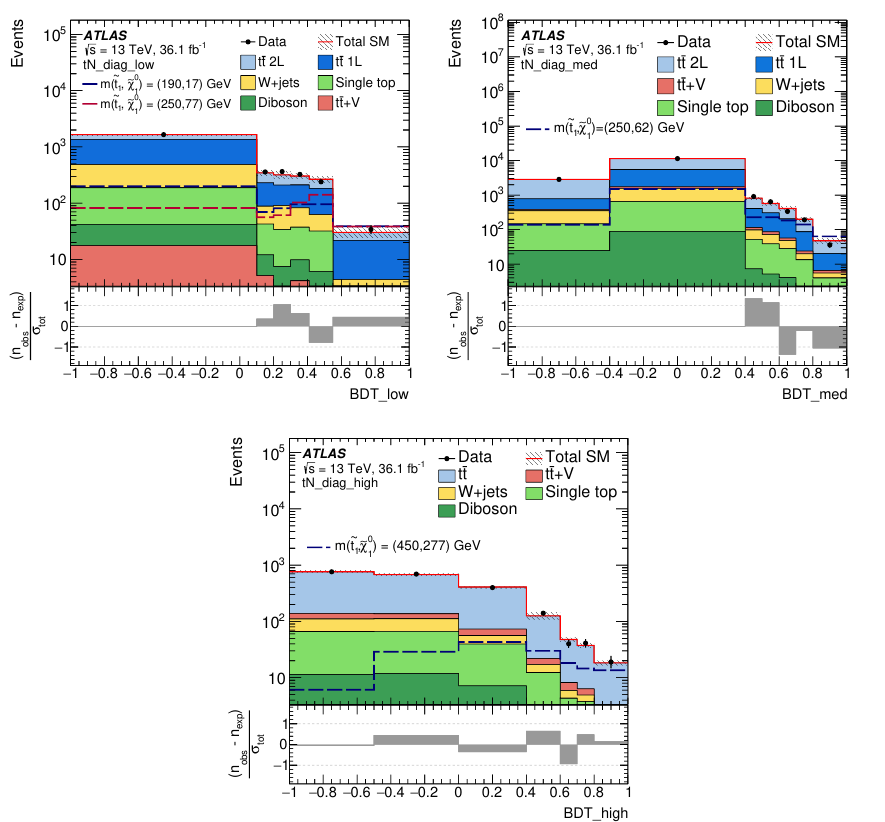
Figure 18 . Distributions of BDT score for the tN diag low (top left), tN diag med (top right), and tN diag high (bottom)